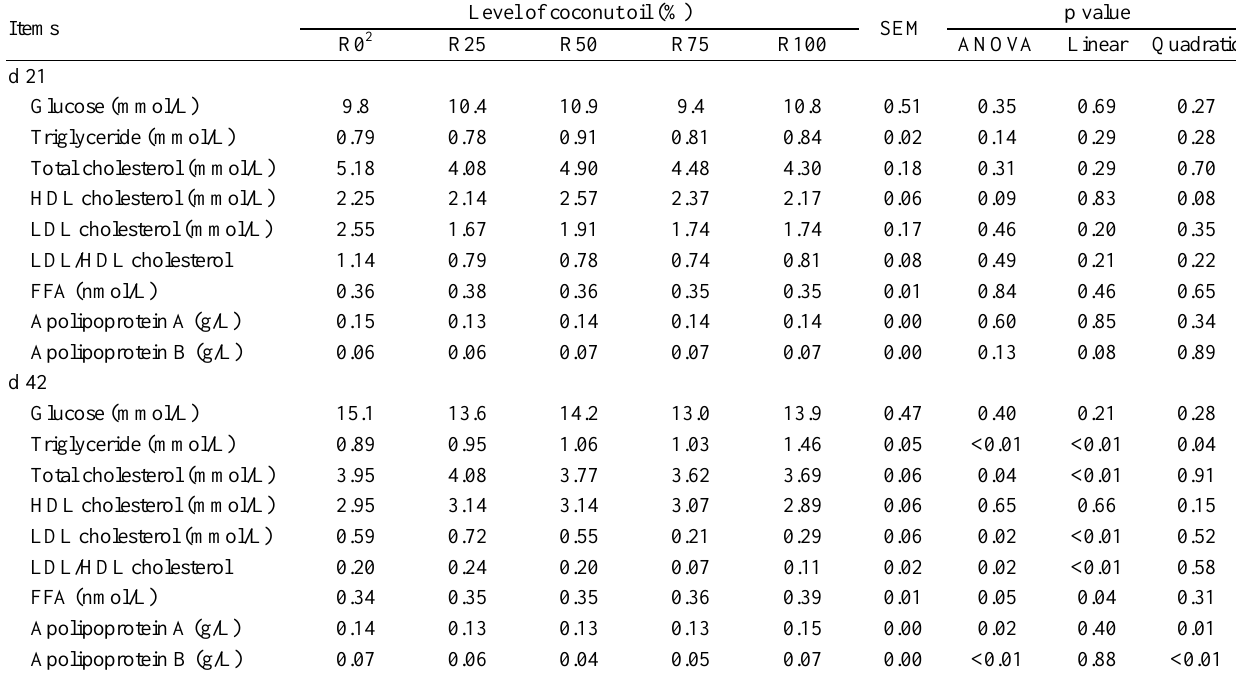
Level of coconut oil (%)